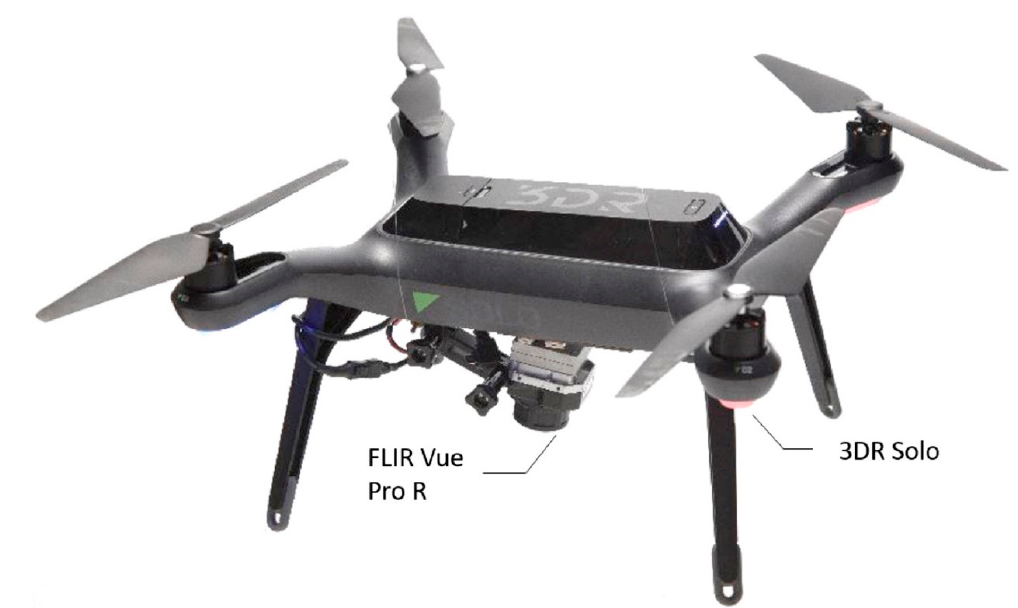
Figure 2. Low-cost commercially available materials used in this study, 3DR Solo quadcopter unmanned aerial vehicle (UAV) with attached forward-looking infrared (FLIR) Vue Pro R thermal infrared camera.